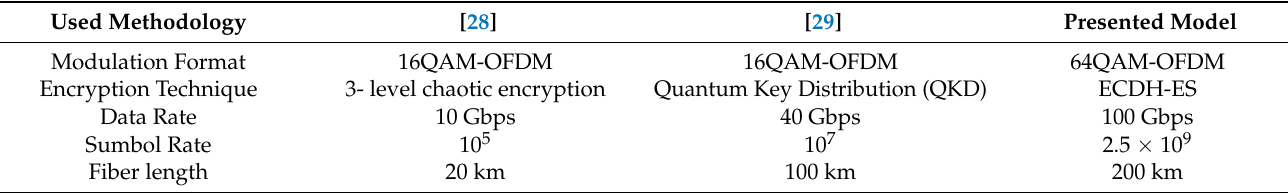
Figure 6. Investing PAPR as a function of CCDF for different RSA, ECC, and ECDH-ES algorithms. Table 2. Comparison of the proposed model with existing approaches.